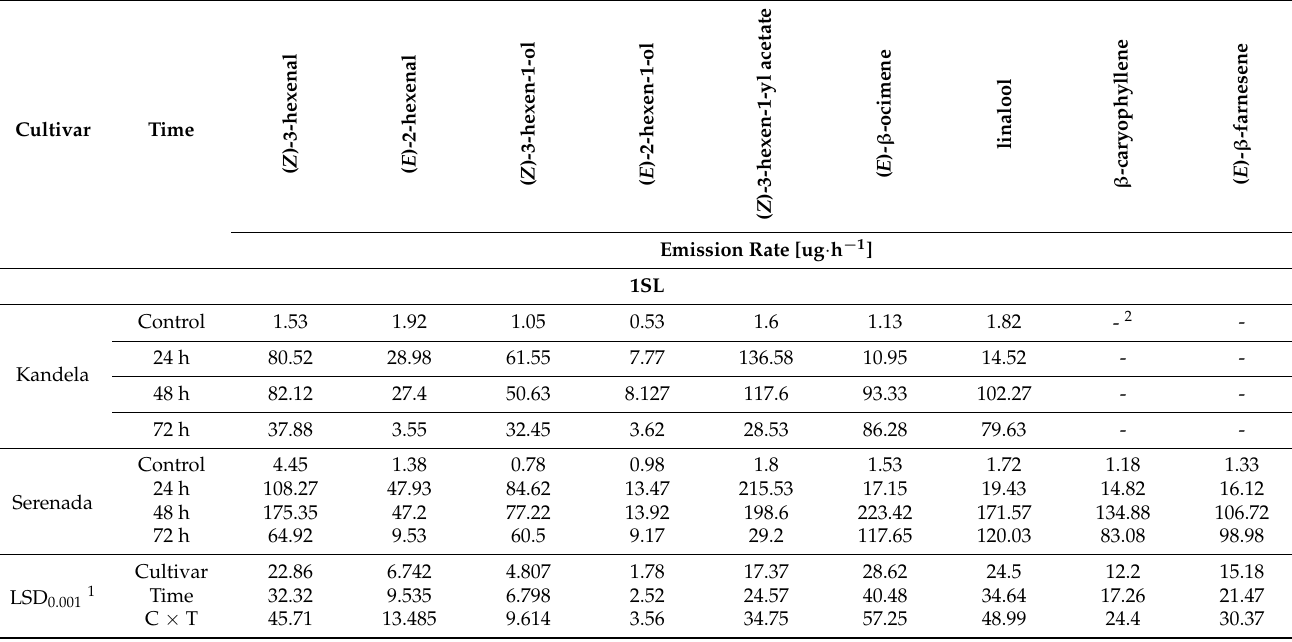
Table 2. Mean values for two wheat cultivars corresponding to the fixed three volatile sample collection times following a given artificial stress (n =